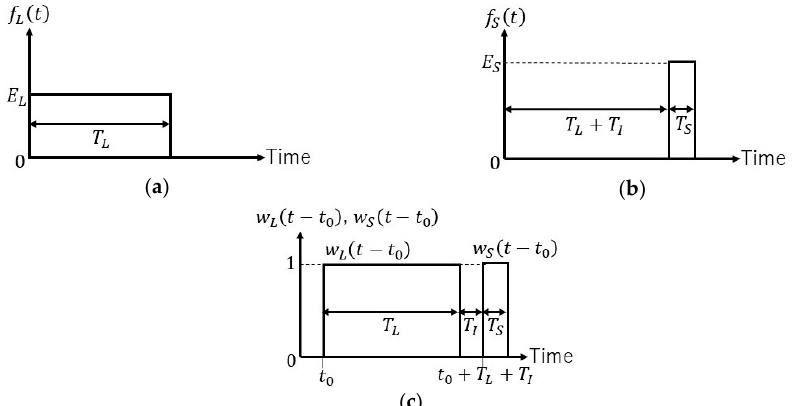
Figure 2. Electric field envelopes and window functions: ( a ) electric field envelope, 𝑓 (cid:3013) (cid:4666)𝑡(cid:4667) , of a long pulse; ( b ) electric field envelope, 𝑓 (cid:3020) (cid:4666) 𝑡 (cid:4667) , of a short pulse; ( c ) a pair of window functions related to long